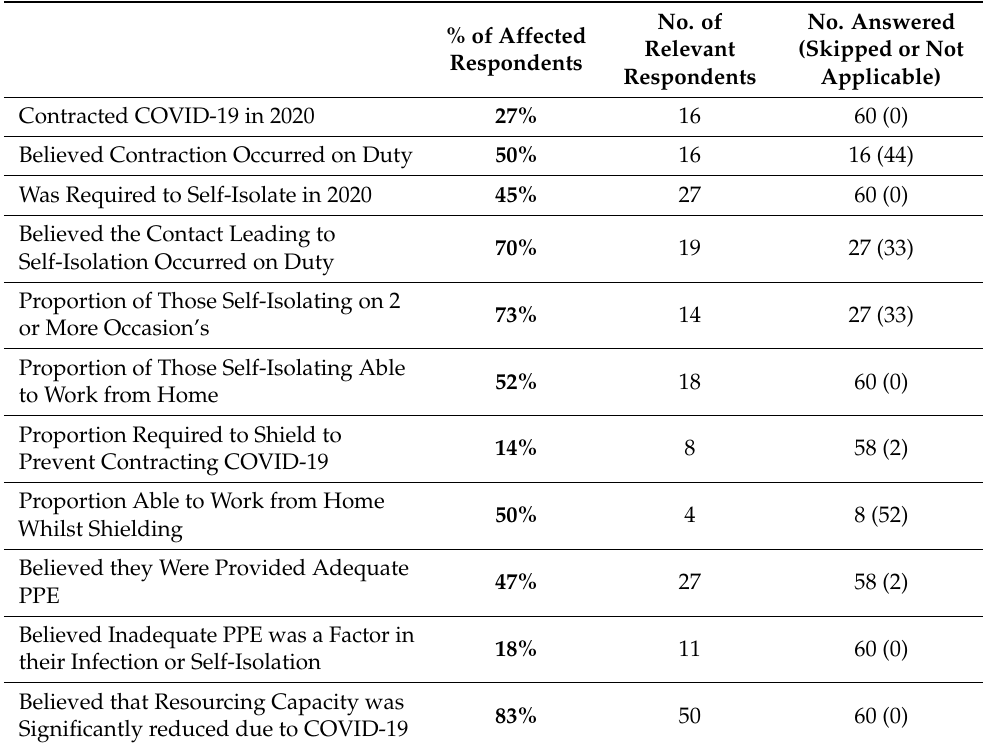
Table 3. Table of survey responses regarding COVID-19 Infection, self-isolation, and working from